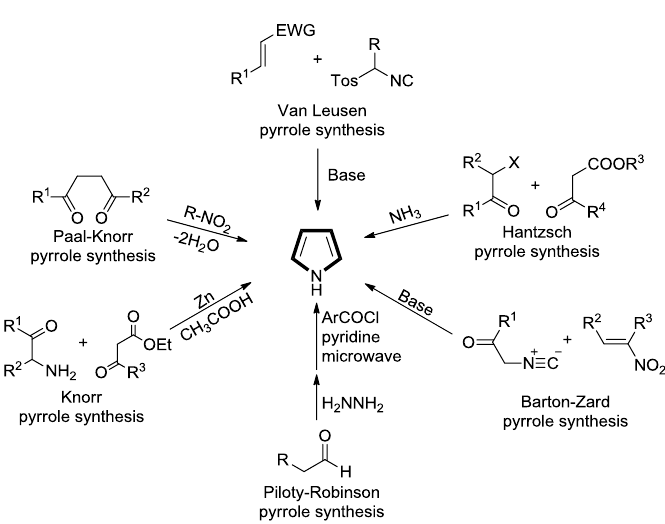
Scheme 1. Typical cycloaddition methods for pyrrole heterocycle and its derivatives.